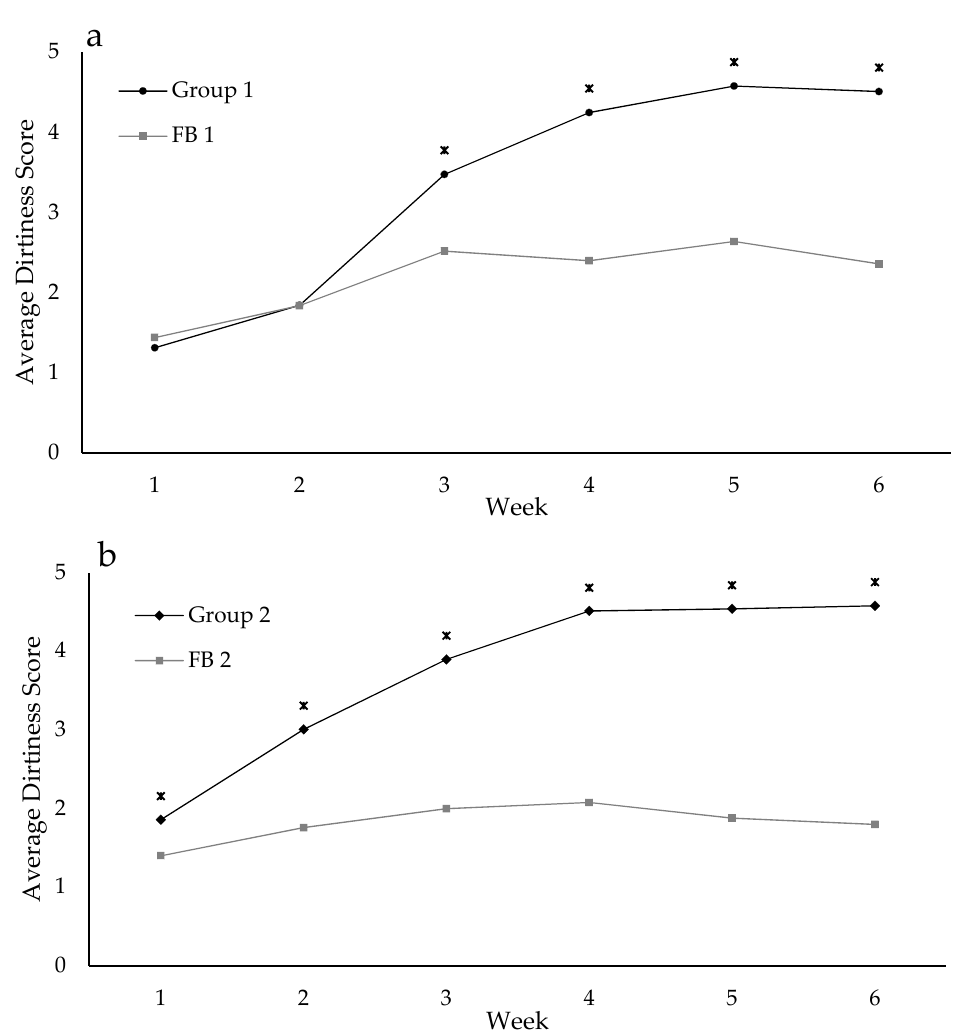
Figure 5. Average dirtiness score for NFP Group 1 and FB 1 ( a ) and NFP Group 2 and FB 2 ( b ) (* indicates significance, p < 0.05, between the groups at each time point) over the five weeks of the trial.